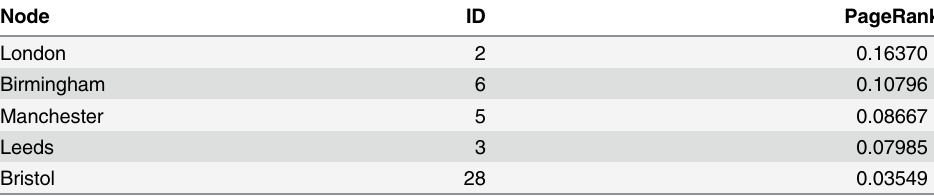
Table 5. Top 5 nodes sorted by